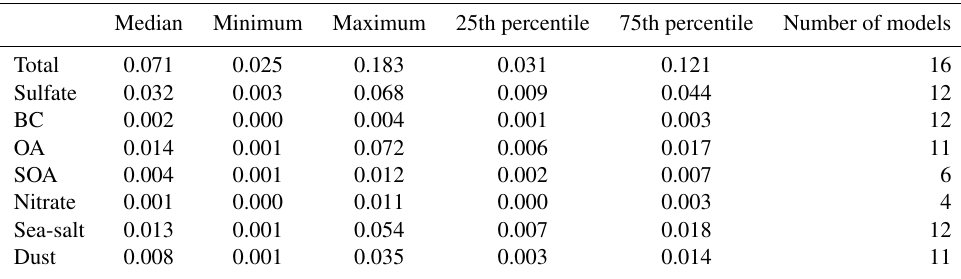
Table 3. Annual mean Arctic (60–90 ◦ N) AOD AeroCom Phase II model median, model range (minimum and maximum), and the 25th / 75th percentile. The number of models for each species is given in the rightmost column. BC is total BC from all sources and OA is total OA from all sources.